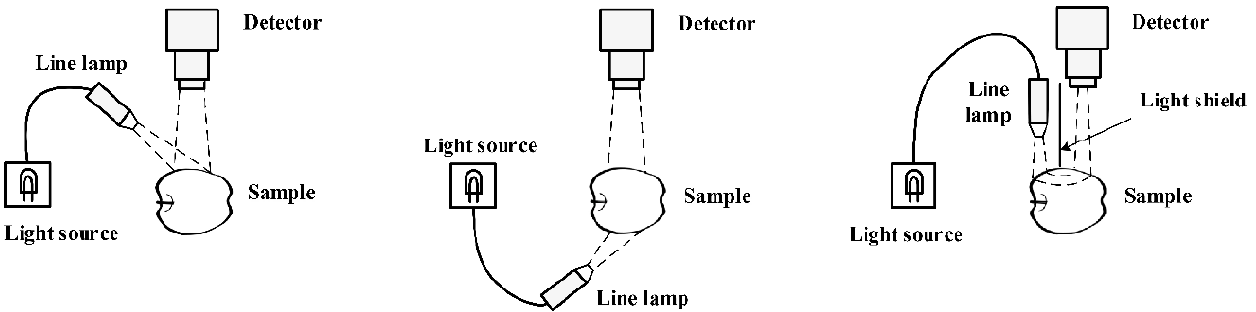
Figure 1. Various modes of HSI technology [26].